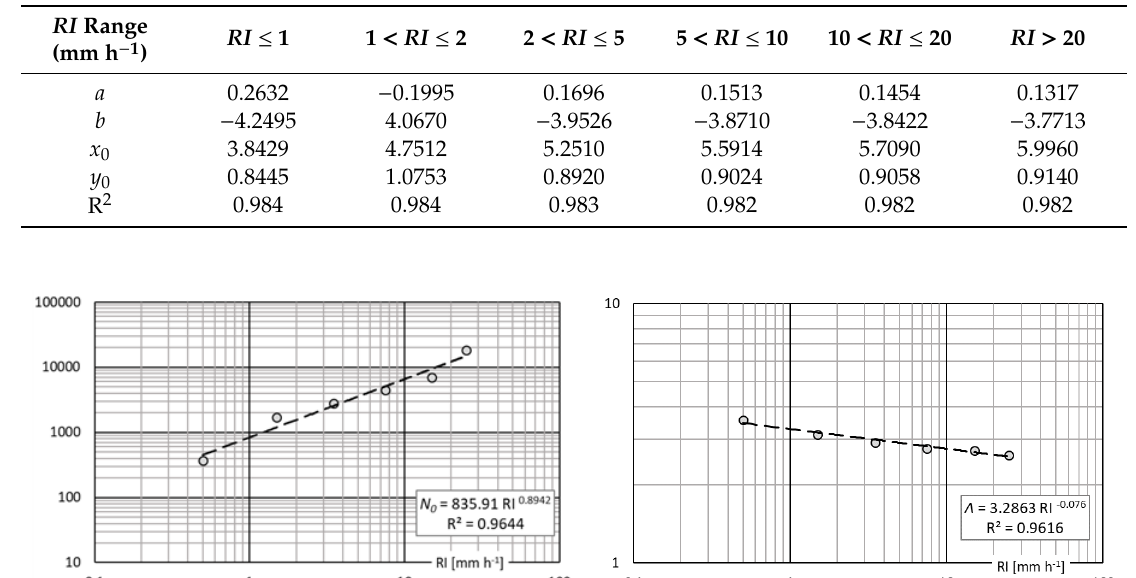
Figure 6. MP parameters associated with the mean values of each RI class (circles) and fitted by power law curves (dashed lines), ( a ) intercept 𝑁 0 and ( b ) exponent Λ .